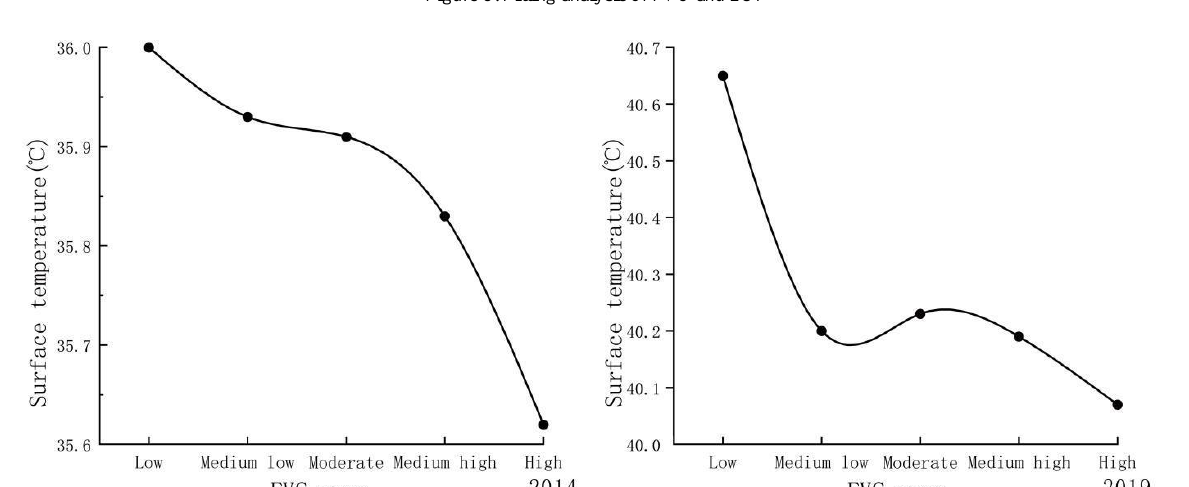
Figure 8. Fitting analysis of FVC and LST